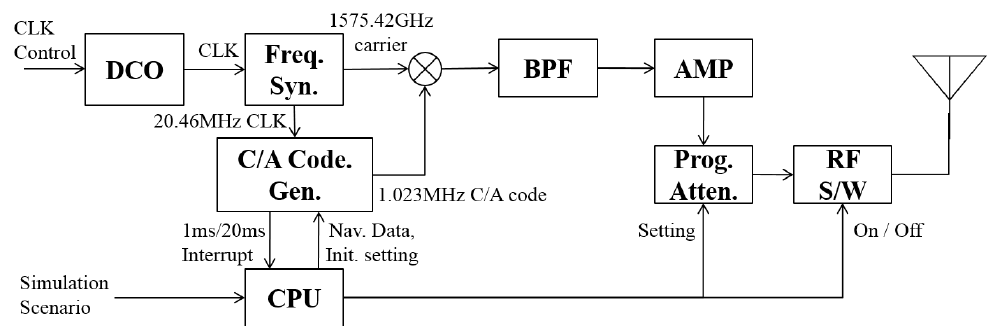
Figure 2. Pseudolite